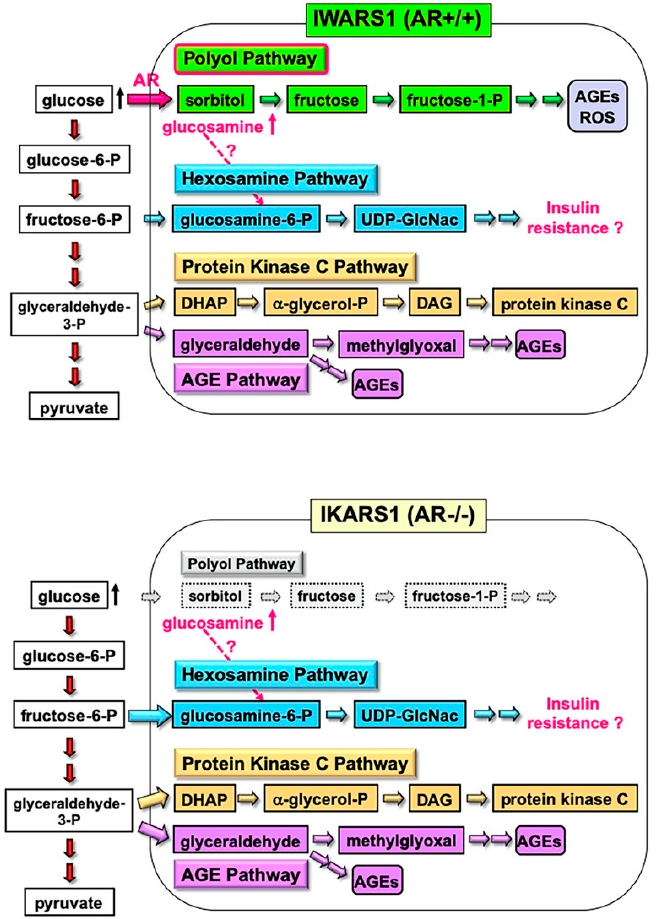
Figure 6. IWARS1 and IKARS1 cells established from wild-type and AR-deficient C57BL/6 mice as useful tools for exploring collateral glucose-utilizing pathways. Our current investigation using these cell lines focuses on the mechanisms of glucosamine accumulation in the PNS under hyperglycemic conditions regardless of the presence or absence of AR, and its association with hexosamine pathway hyperactivity that may impair insulin signaling.